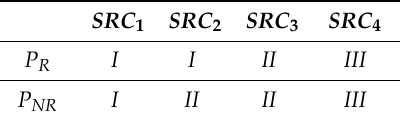
Table 2. Choice of the variant according to the surface and regularity